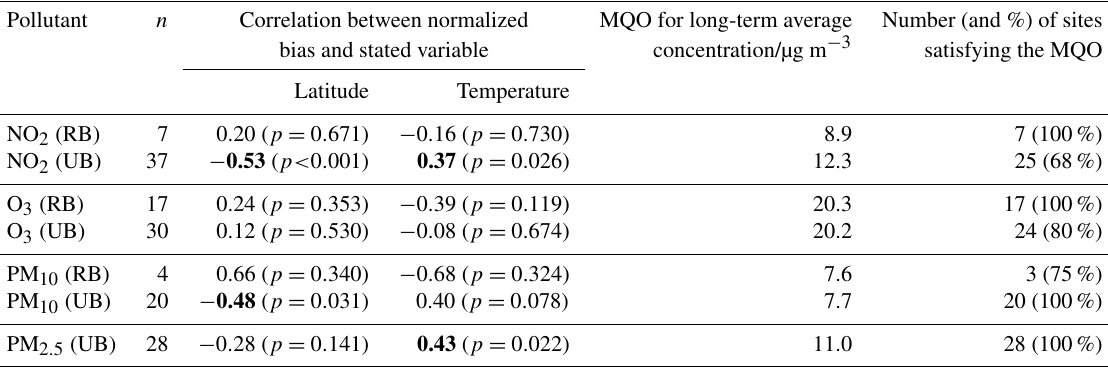
Table 2. Correlation of the normalized bias between model and measurement 10-year means of pollutant daily metrics (2-year mean for PM 2 . 5 ) at a site with the latitude or with the 10-year mean modelled temperature at that site. Correlations significant at p< 0 . 05 are highlighted in bold. RB, rural background; UB, urban background. No data for PM 2 . 5 (RB) since only n = 2 sites. Also presented in the penultimate column is the maximum bias between model and measurement that forms the model quality objective (MQO) for long-term averaged values of the pollutant concentration at the given site type, as calculated using the formulae published in FAIRMODE project WG 1 documents at http://fairmode.jrc.ec.europa.eu (as at March 2017) and allowing for variable measurement uncertainty using the measured values from this study. These values define the positions of the green lines in each panel of Fig. 1. The final column gives the number (and %) of sites that satisfy this MQO, i.e. which lie within the green lines of Fig.